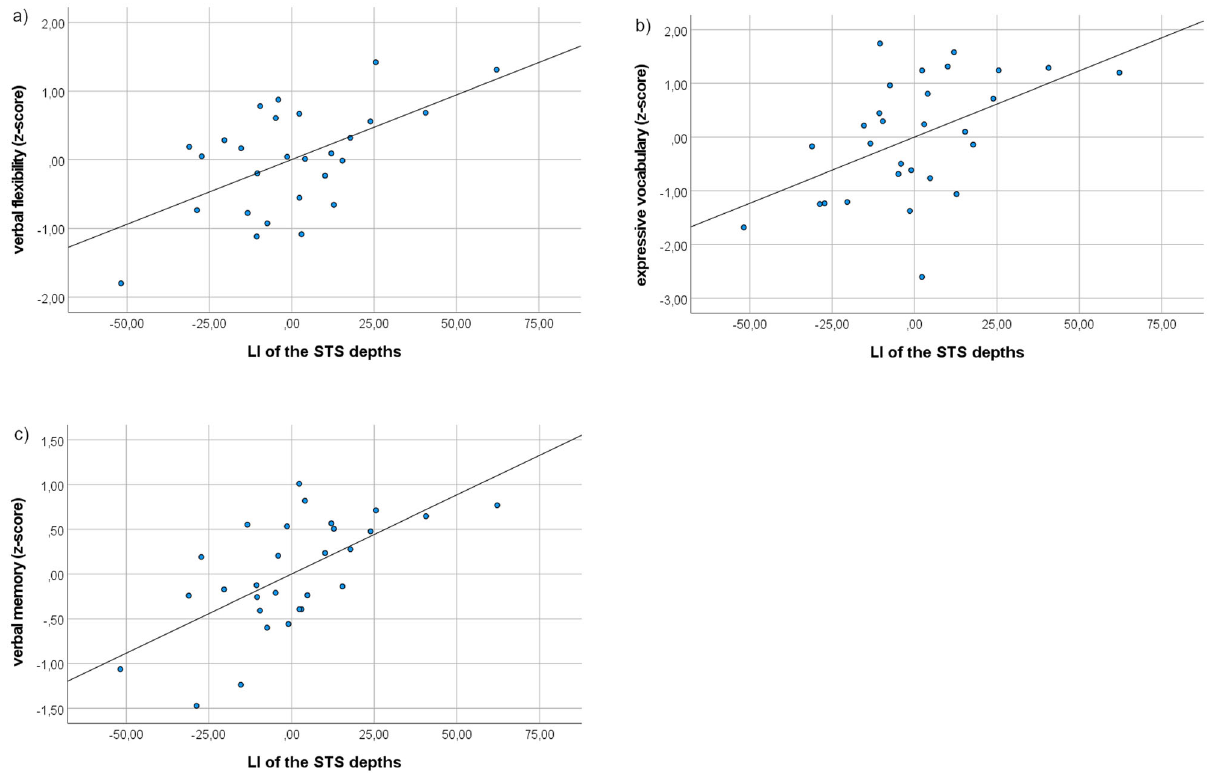
Fig. 1 LIs of the fetal STS depths predict later. a Verbal fl exibility, b expressive vocabulary, and c verbal memory, indicated by multiple linear regression and adjusted for nonverbal perceptual reasoning ( n = 29).